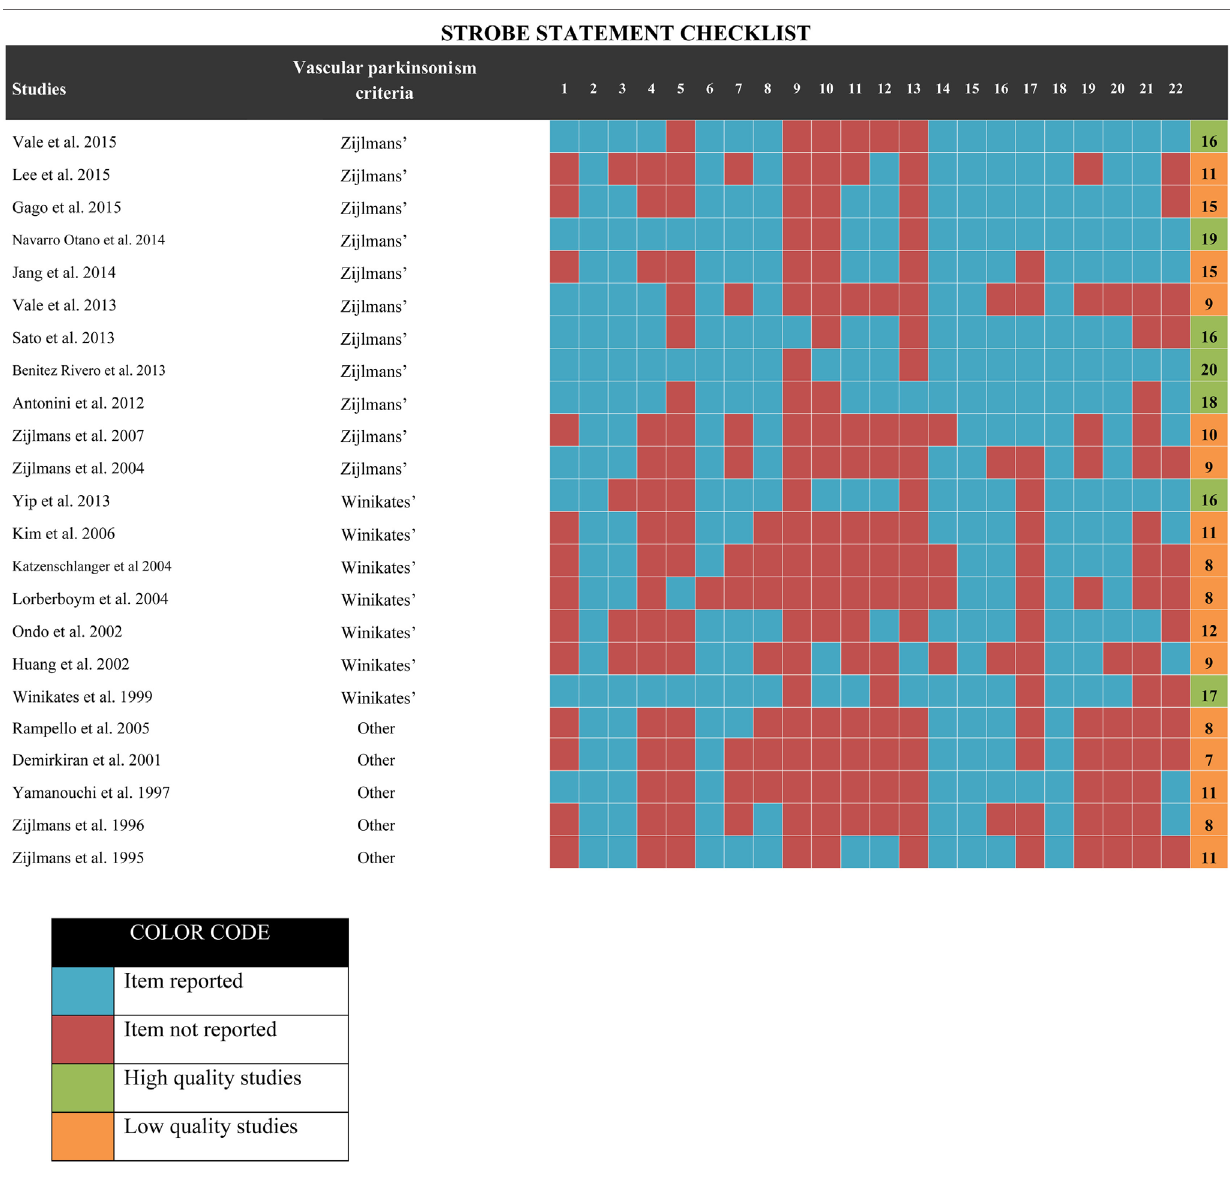
taBle 3 | STROBE checklist